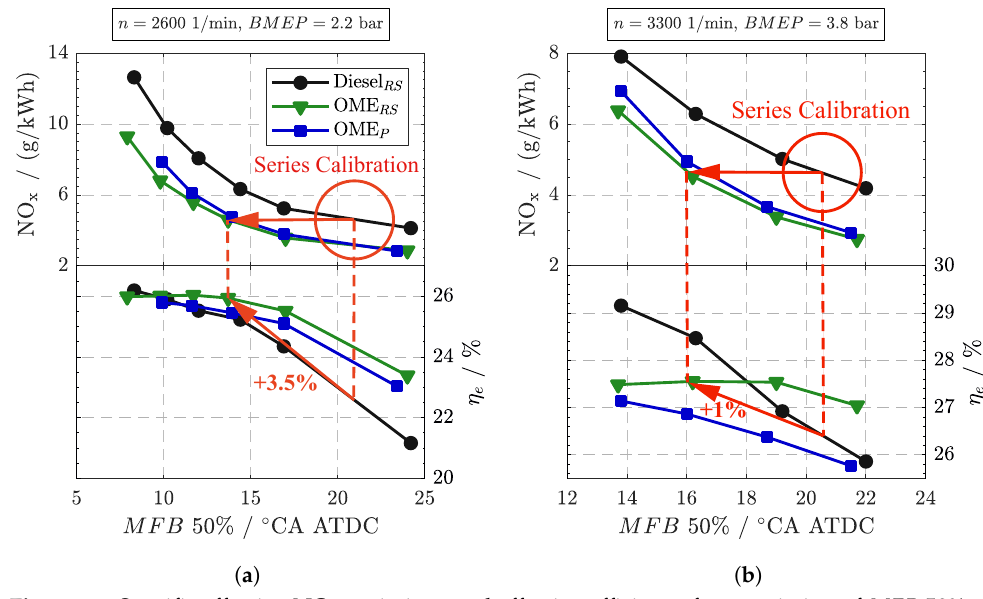
Figure 10. Specific effective NO x -emissions and effective efficiency for a variation of MFB 50% at OP 1 ( a ) and OP 2 ( b ) for diesel and two different nozzles in OME